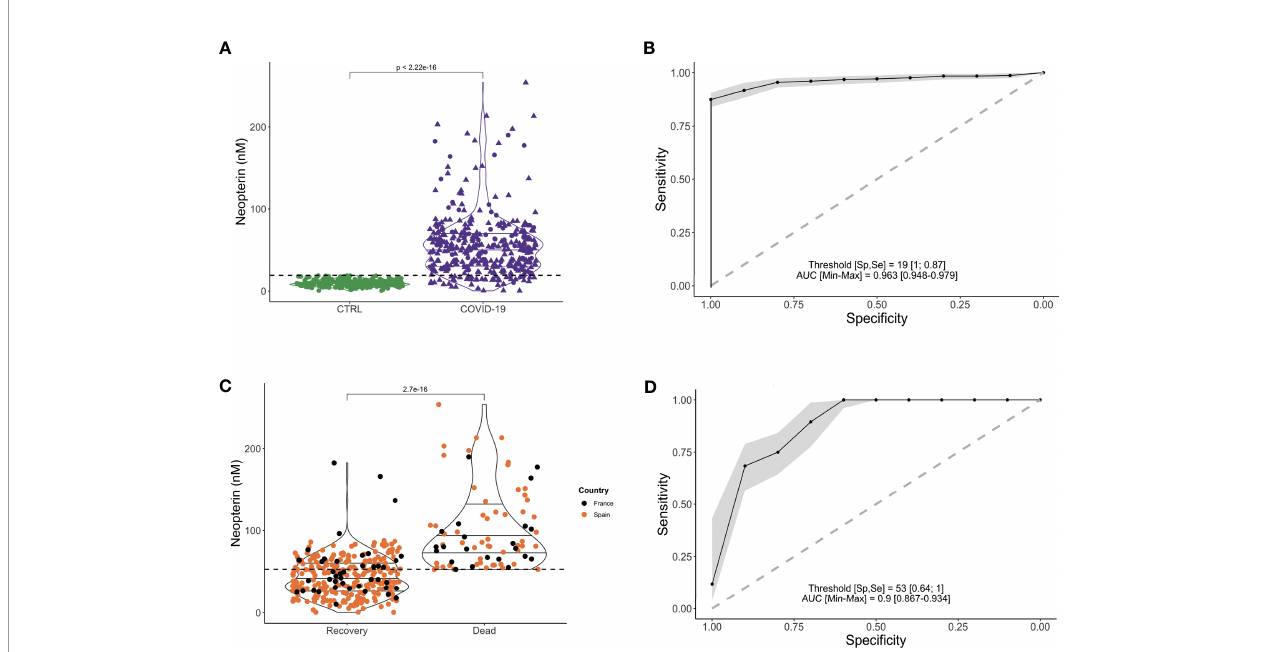
FIGURE 2 | Higher serum level of neopterin is associated with Covid-19 infection and fatal outcome. (A) Violin plot representing serum neopterin levels (in nM) strati fi ed according to infectious status (CTRL (uninfected healthy donors, uninfected, in green); Covid-19 (SARS-CoV-2 infected individuals, in purple). Shape of dots represents country of inclusion of infected patients (Circles for France; Triangles for Spain). Dotted line shows the threshold (19nM) enabling the strati fi cation of healthy vs infected patients. (B) Receiver Operating Characteristics (ROC) curve depicting sensitivity and speci fi city of prediction model for SARS-CoV-2 infection based on neopterin level. Grey zone represents con fi dence interval. AUC= 0.963; Speci fi city = 100%; Sensitivity= 87%; threshold = 19nM. (C) Violin plot representing serum neopterin levels (in nM) strati fi ed according to clinical outcome (RECOVERY (survivors) or DEAD (non-survivors). Colors of dots represent country of inclusion of infected patients (Black circles for France; Orange circles for Spain). Dotted line shows the threshold (53nM) enabling the strati fi cation of deceased vs survivors. (D) Receiver Operating Characteristics (ROC) curve depicting sensitivity and speci fi city of prediction model for fatal outcome based on neopterin level. Grey zone represents con fi dence interval. AUC = 0.94; Speci fi city = 100%; Sensitivity = 64%; threshold =